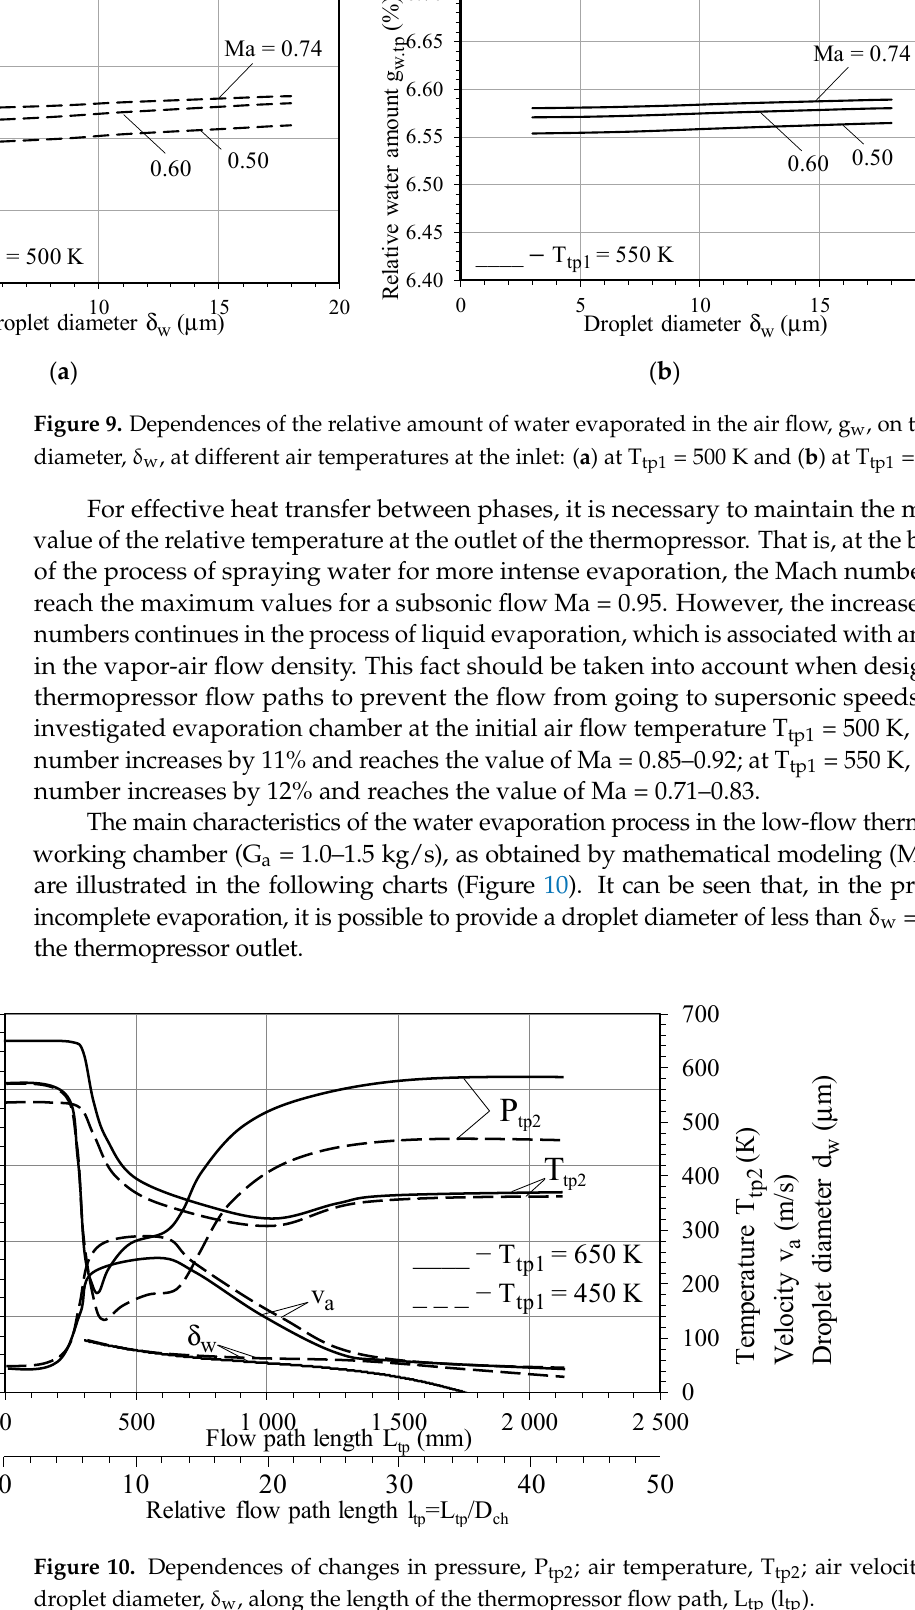
Energies 2022 , 15 , 2250 15 of 29 ( c ) Figure 8. Dependences of the relative temperature, T tp1 /T tp2 , at the T tp1 = 500 K ( a ) and at the T tp1 = 550 K ( b ) and temperature at the end of the thermo-gas-dynamic compression process, T tp2 , ( c ) on the droplet diameter, δ w , at different air temperatures at the inlet. Depending on the initial parameters (air temperature, Mach number at the evapora- tion chamber inlet and droplet diameter), the humidified air temperature at the evapora- tion chamber outlet decreases: at T tp1 = 500 K, it decreases by Δ T tp = 160–165 K; at T tp1 = 550